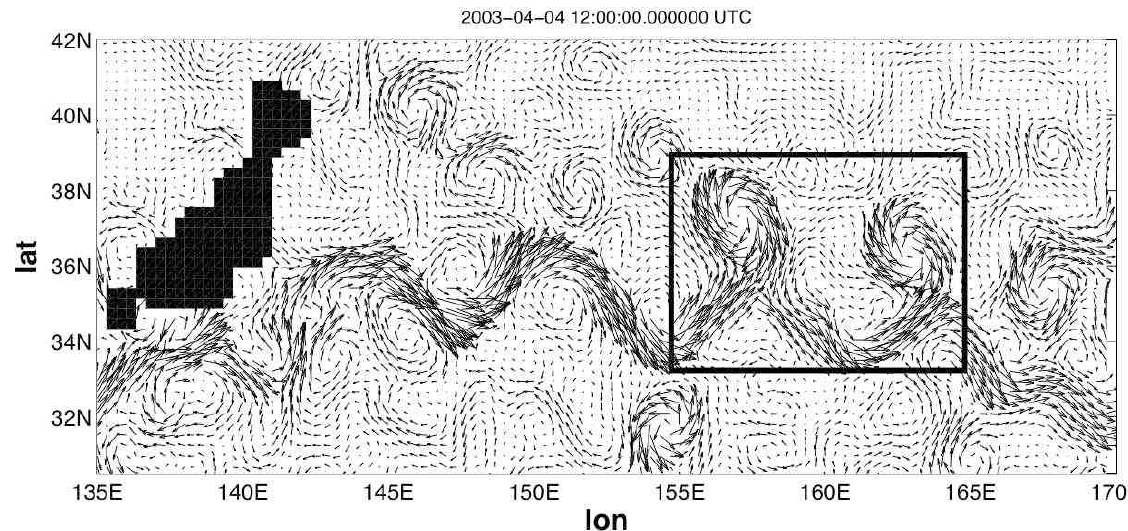
Fig. 1. Velocity field of the Kuroshio current on 4 April 2003. The square highlights our main focus area. Maximum values of the velocity field are about 3.65ms − 1 . (Figure taken from Mendoza et al.,